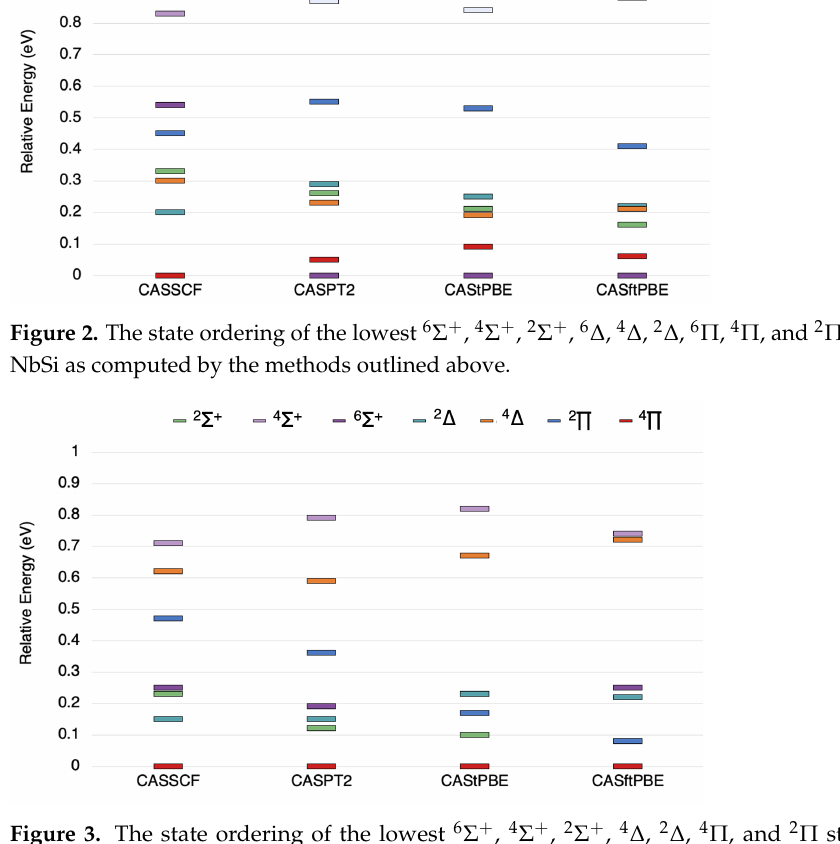
Figure 3. The state ordering of the lowest 6 Σ + , 4 Σ + , 2 Σ + , 4 ∆ , 2 ∆ , 4 Π , and 2 Π states of TaSi as computed by the methods